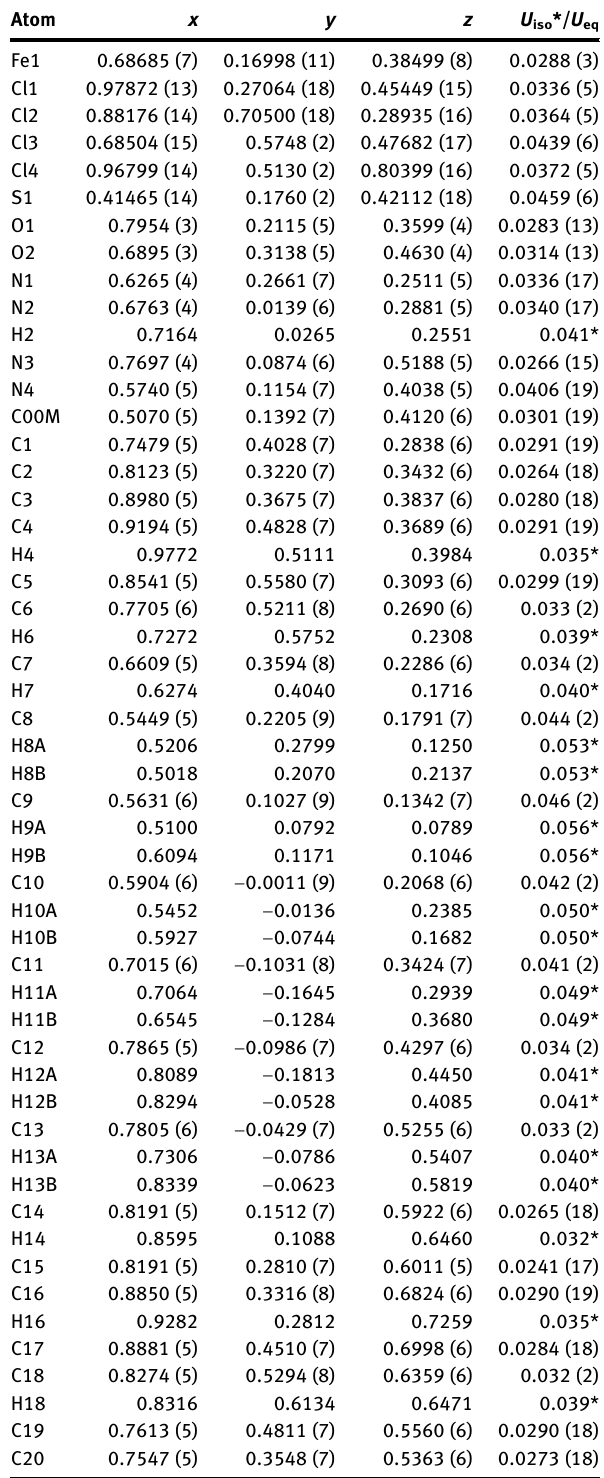
Table  : Fractional atomic coordinates and isotropic or equivalent isotropic displacement parameters (Å 